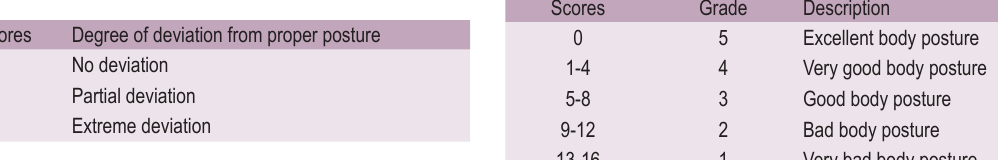
TABLE 2. Posture Assessment according to the Negative Score Model - Wolanski